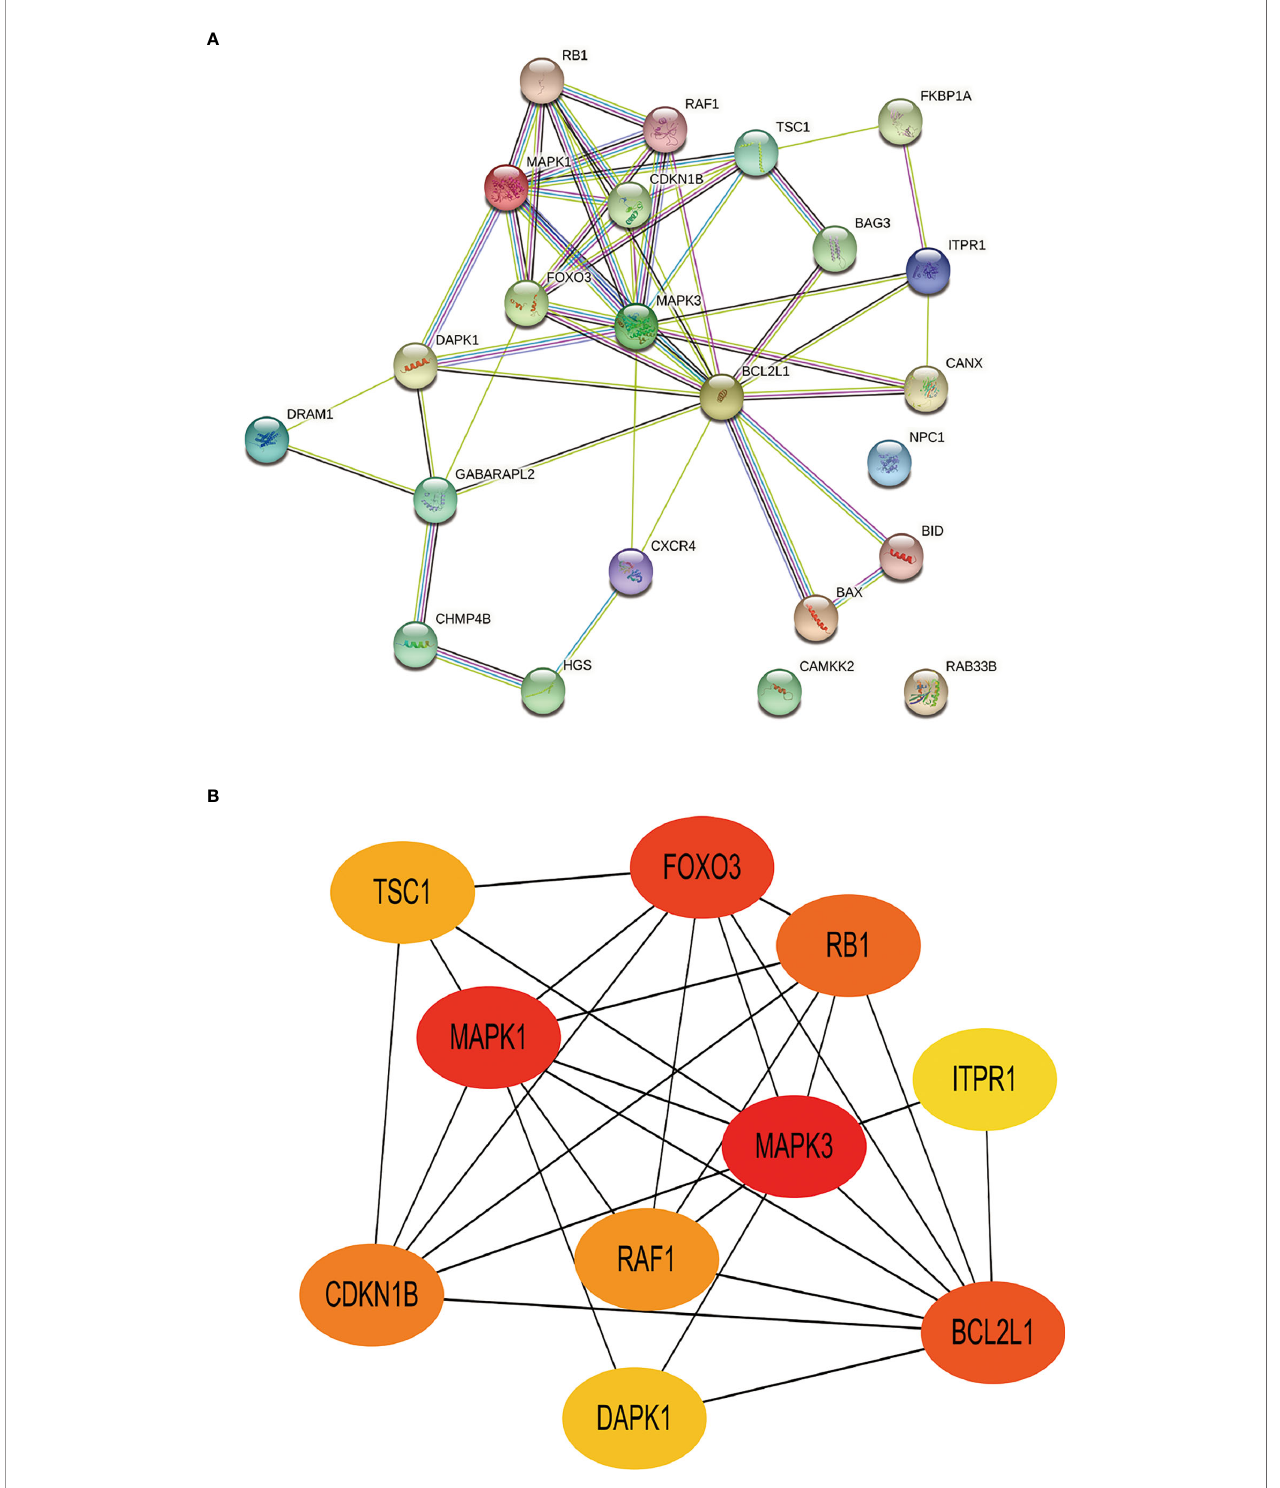
FIGURE 7 | Construction of PPI network and identi fi cation of hub genes. (A) , The PPI between 23 differentially expressed autophagy-related genes was constructed by using the STRING database. The node represents the gene, and the edge represents the relationship between the genes. (B) , The top 10 key genes were screened through the PPI network map. Different colors in the image only represent different genes and have no other substantive meaning. PPI, protein-protein